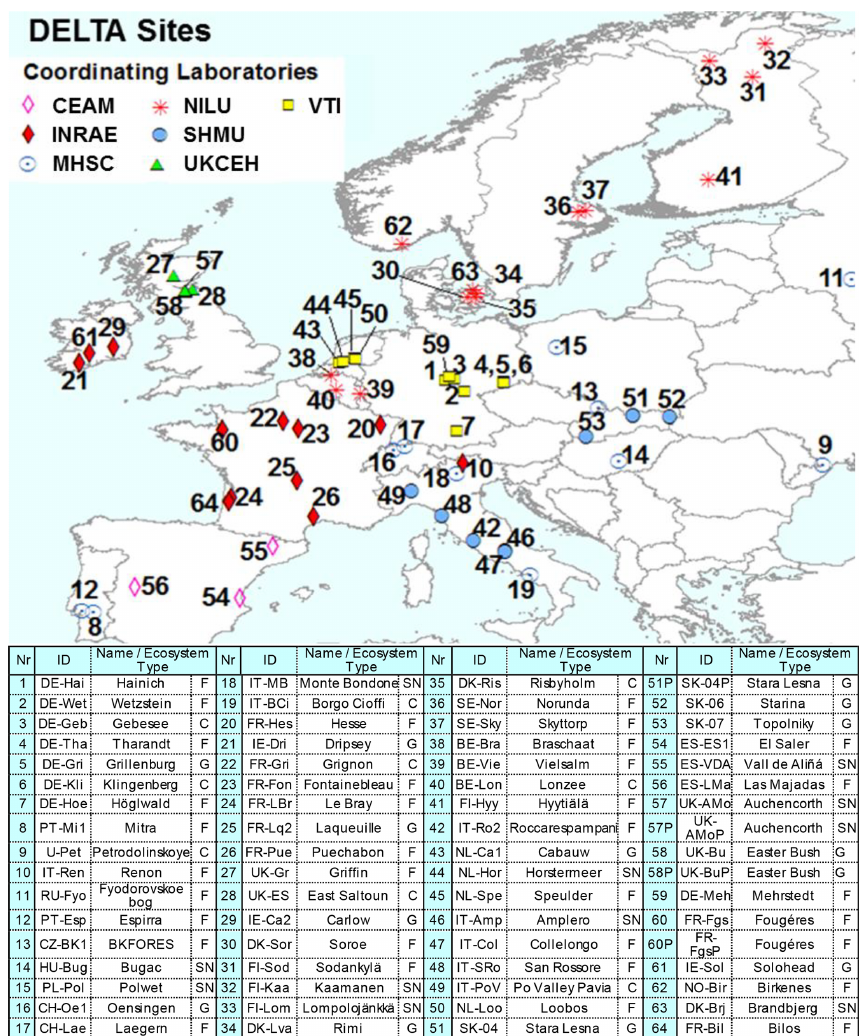
Figure 2. NitroEurope (NEU) DELTA ® network sites operated between 2006 and 2010. The colour of the symbols indicates the responsible laboratories: CEAM (the Mediterranean Centre for Environmental Studies), vTI (von Thunen Institut), INRAE (French National Research Institute for Agriculture, Food and Environment), MHSC (Meteorological and Hydrological Service of Croatia), UKCEH (UK Centre for Ecology & Hydrology), NILU (Norwegian Institute for Air Research), SHMU (Slovak Hydrometeorological Institute). Ecosystem types are C (crops), G (grassland), F (forests), and SN (short semi-natural; includes moorland, peatland, shrubland, and unimproved and upland grassland). Replicated (P: parallel) DELTA measurements are made at four sites: SK04/SK04P; UK-AMo/UK-AMoP (NH 3 and NH + UK-Bu/UK-BuP, and FR-Fgs/FR-FgsP (NaCl-coated denuders instead of K 2 CO 3 –glycerol in sample